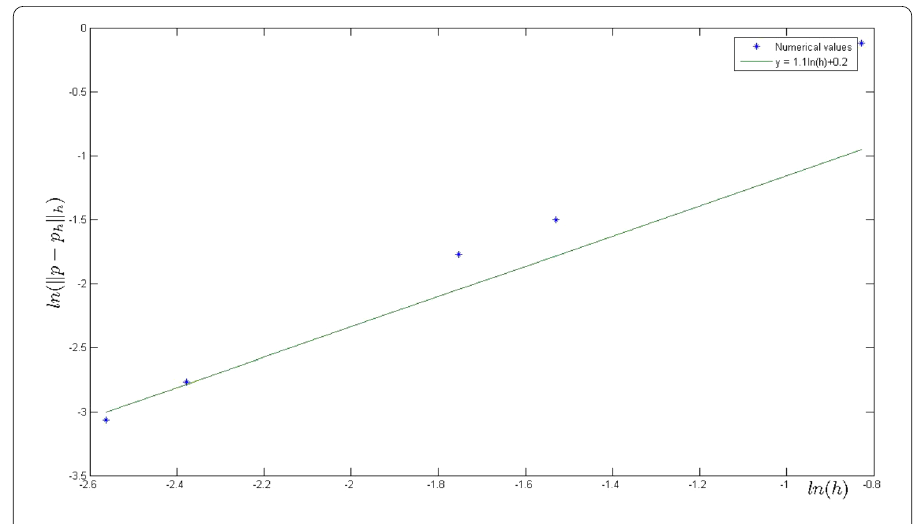
Figure 2 Errors (cid:10) p – p h (cid:10) h